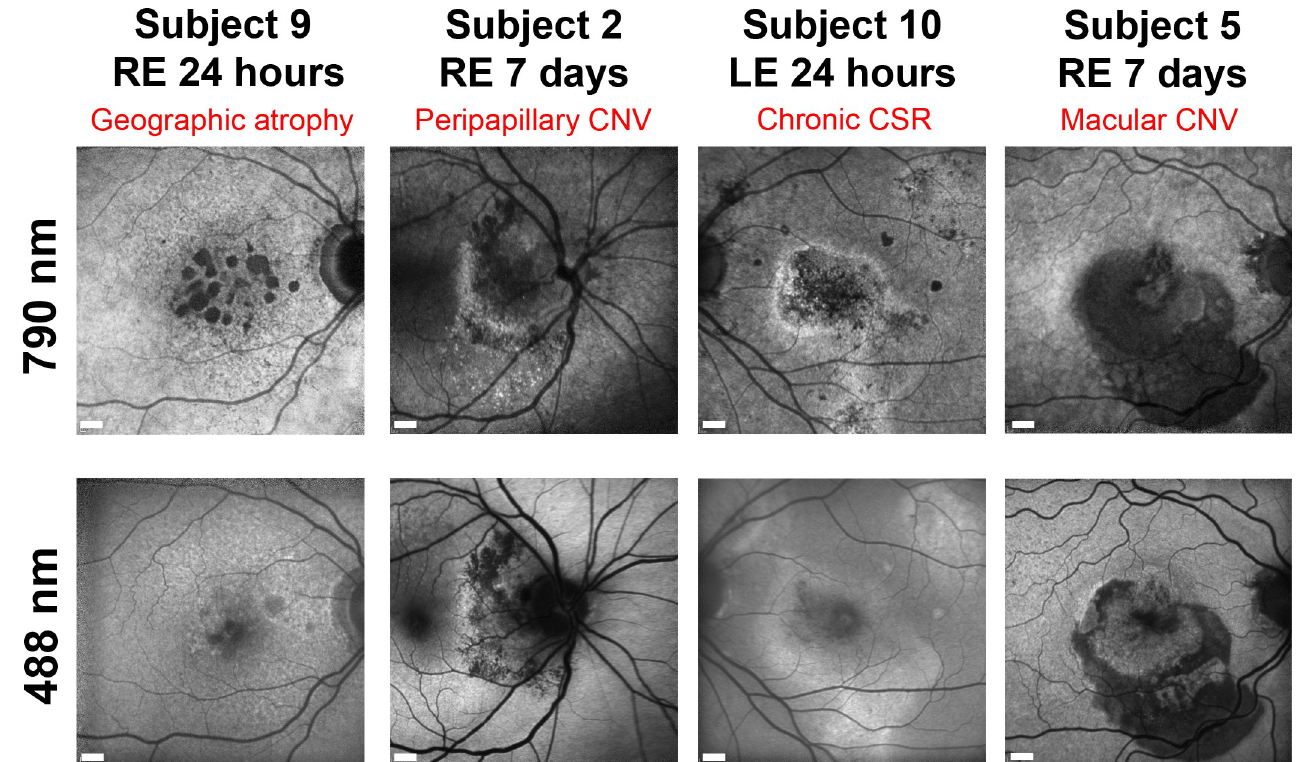
Fig 1. Differences in retinal images between late near infrared imaging following ICG (DNIRA) and standard 488 nm autofluorescence. Four examples from the eyes of different subjects illustrate different appearances that provide complementary information on RPE health. Retinal ICG fluorescence 790 nm excitation channel images are shown alongside matched 488 nm excitation autofluorescence images. CNV = Choroidal neovascular membrane, CSR = Central serous retinopathy. LE = left eye, RE = right eye. Scale bars = 600 μ m.